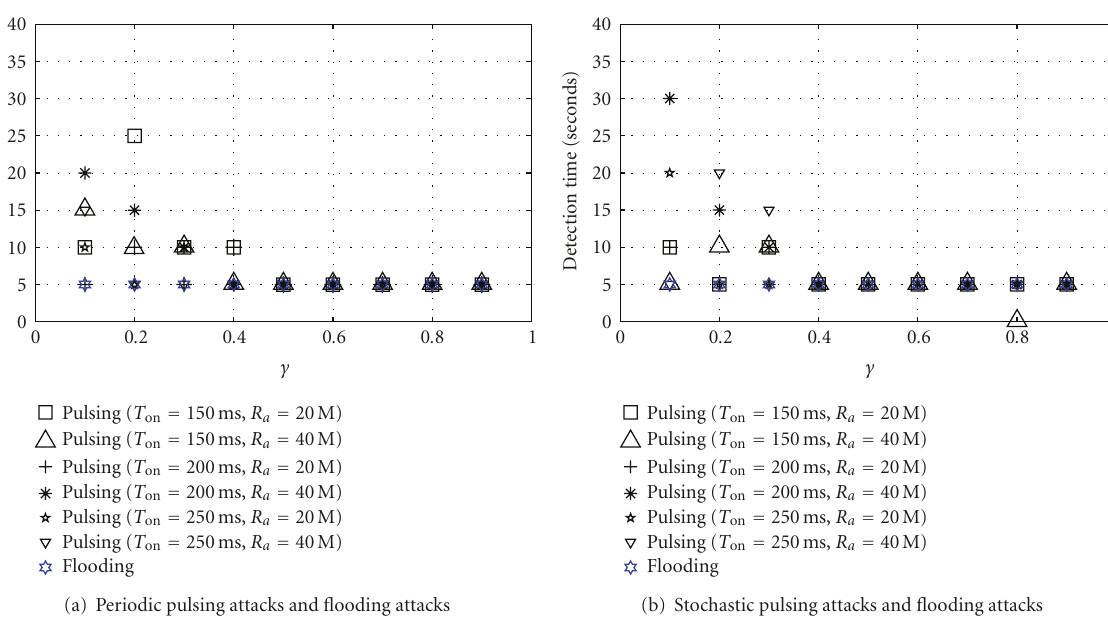
Figure 6: Detecting flooding attacks using Vanguard.